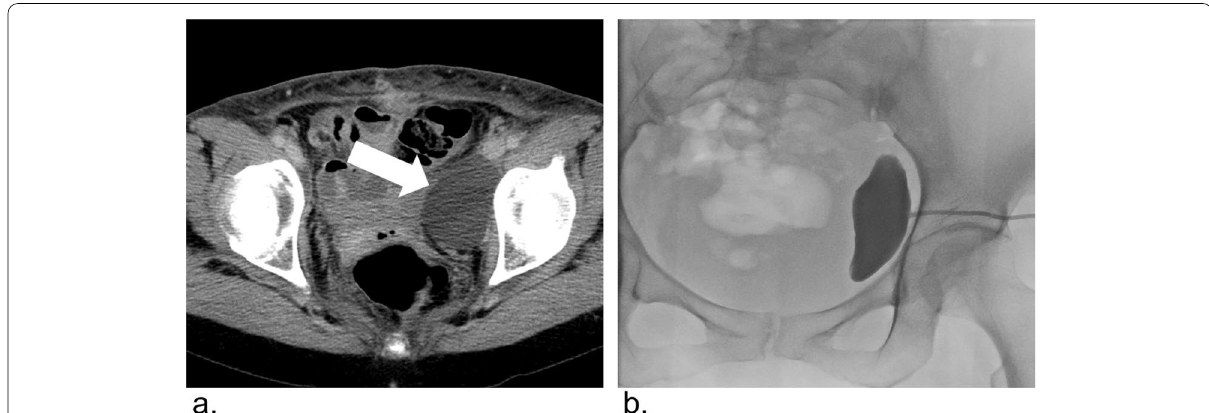
Fig. 1 a Contrast-enhanced computed tomography (CT) after gynecological cancer surgery in a 60-year-old woman presenting with left low leg lymphedema. CT shows left pelvic lymphocele (white arrow). b Cavitogram shows no leakage of the